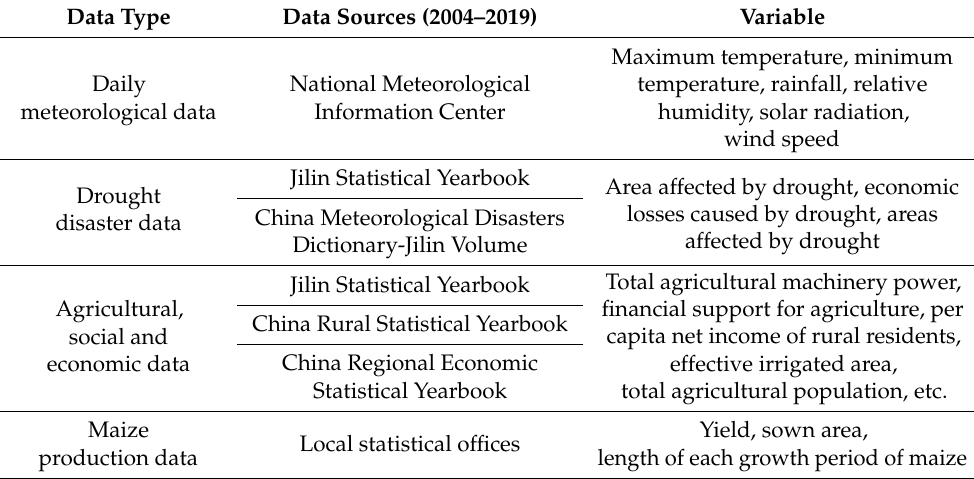
Table 1. Data and indicators used in this